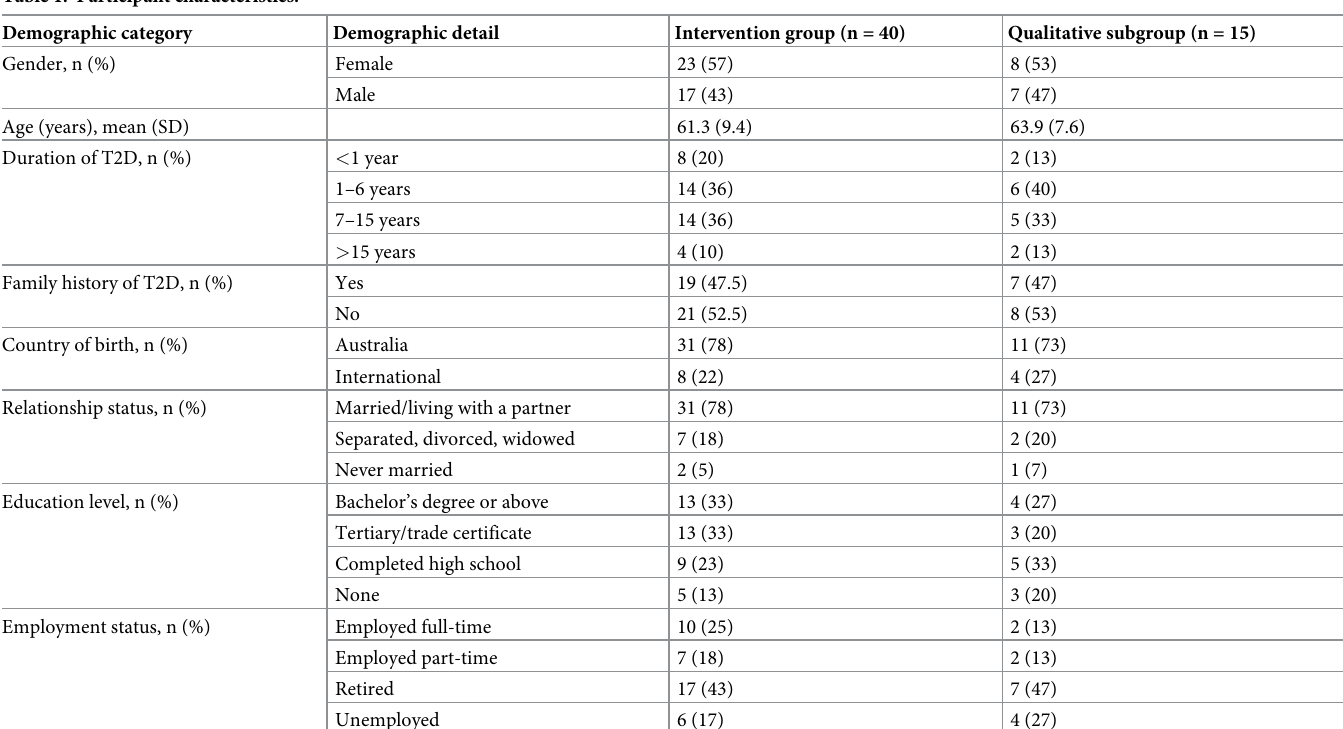
Table 1. Participant characteristics.